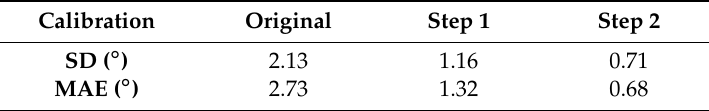
Figure 13. AOP-error comparison before and after calibration. ( a ) AOP-error curve comparison; ( b ) AOP error distribution. Table 6. Statistics comparison of AOP error.